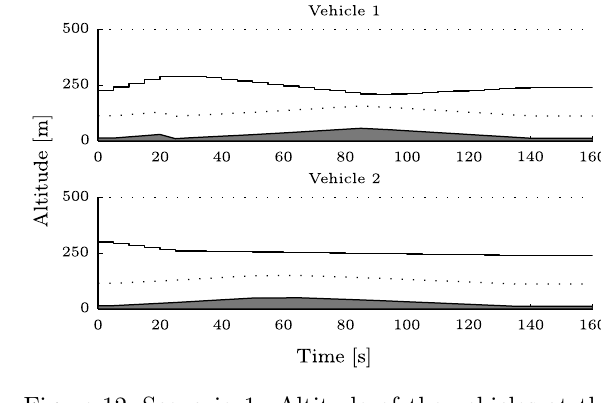
Figure 12: Scenario 1: Altitude of the vehicles at the final iteration. The shaded region is the ter- rain height, and the dashed lines are the up- per and lower bounds on the altitude of the vehicles. The actual altitude of the vehicles is depicted with the continuous line during the mission, and even after they reach the final waypoint. When the final waypoint is reached they are expected to be landed manually by a